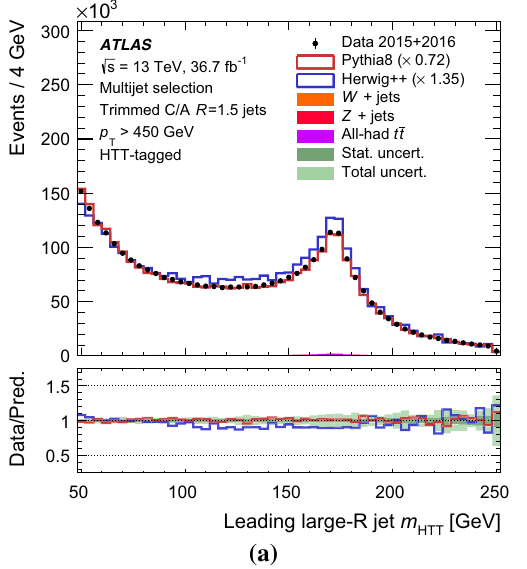
Fig. 30 A comparison of the observed data and predicted MC distri- butions in the multijet ( a ) and γ + jet ( b ) event samples for the HEP- TopTagger mass. The data-driven normalisation correction, described in Sect. 6.2.1, is shown in the legend beside the specific sample to which it applies. Systematic uncertainties are indicated as a band in the lower panel and include all experimental uncertainties related to the selection